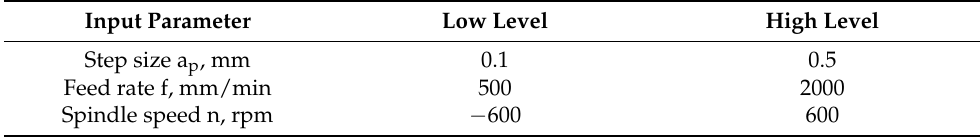
Table 3. The range of experiments presented by the input